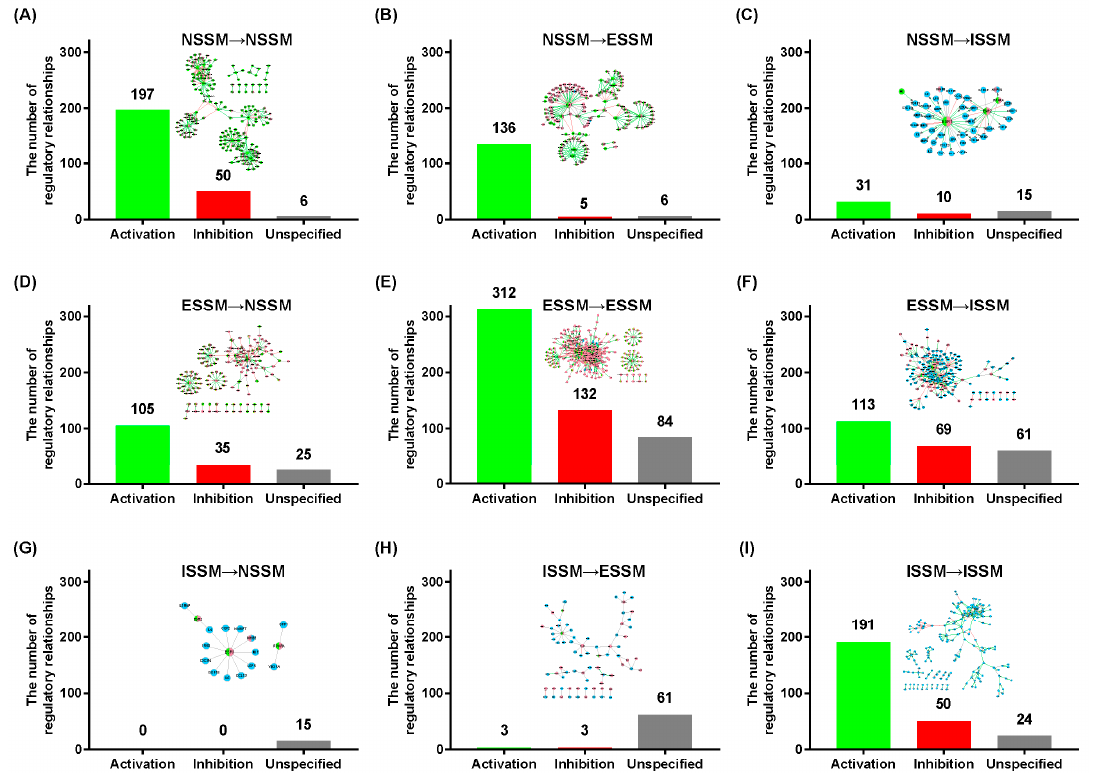
Figure 2. The regulatory relationships among neuroendocrine immunomodulation (NIM) signaling molecules belonging to different systems in the core molecular network. The x axis represents the three types of regulatory relationship (activation, inhibition, unspecified), and the y axis represents the number of regulatory relationships. The meaning of the network elements is the same as that shown in Figure 1. ( A ) The internal regulatory relationship of NSSM and its network form; ( B ) The regulatory relationship from NSSM to ESSM and its network form; ( C ) The regulatory relationship from NSSM to ISSM and its network form; ( D ) The regulatory relationship from ESSM to NSSM and its network form; ( E ) The internal regulatory relationship of ESSM and its network form; ( F ) The regulatory relationship from ESSM to ISSM and its network form; ( G ) The regulatory relationship from ISSM to NSSM and its network form; ( H ) The regulatory relationship from ISSM to ESSM and its network form; ( I ) The internal regulatory relationship of ISSM and its network form. Nervous system signaling molecules, NSSM; endocrine system signaling molecules, ESSM; immune system signaling molecules,